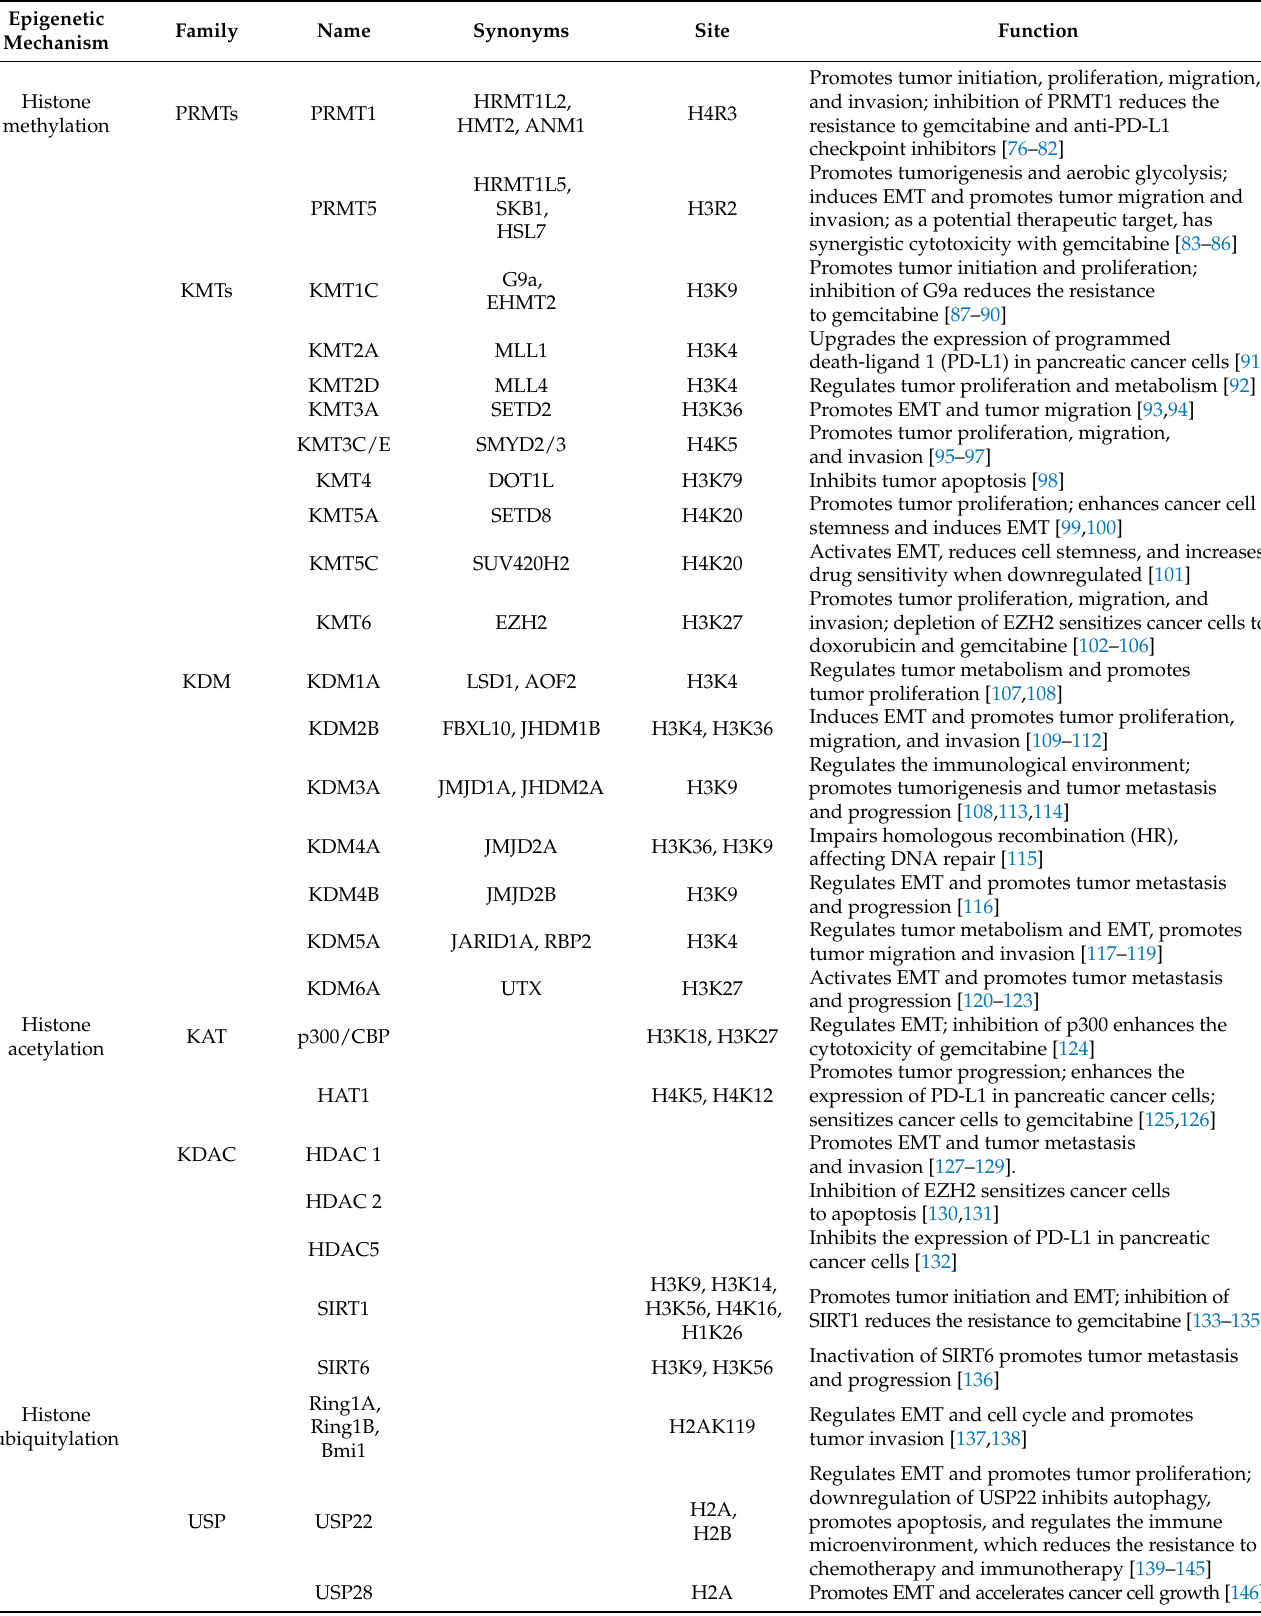
Table 1. Histone-modifying enzymes in pancreatic